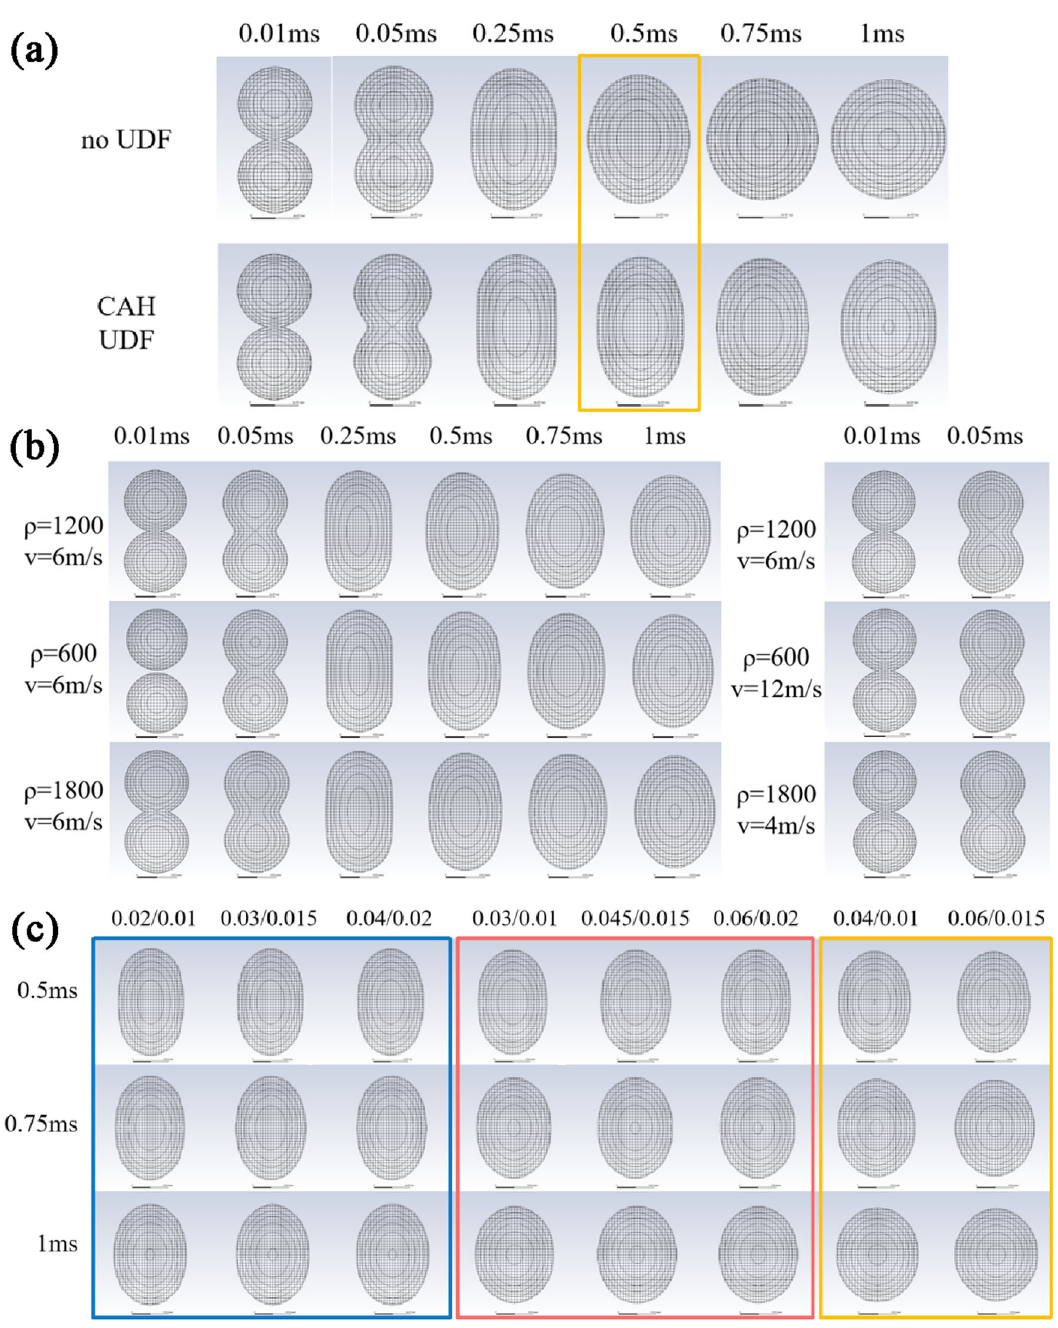
Fig. 4 Results of two droplets fusion simulation. a Simulated two-droplet fusion morphology of cases without a UDF and with the CAH UDF. b Simulated two-droplet fusion morphology of cases with different densities and impact velocities. c Simulated two-droplet fusion morphology of cases with different surface tensions and viscosities. All pictures are top views of simulated two-droplet fusion morphology. a Shows the difference between cases without UDFs and with CAH UDF. b Results reveal that the in fl uence of impact velocity and density mainly worked in the early stage(<0.05 s) and can be ignored in the whole printing process. c Shows that the same value of surface tension/ viscosity is the major factor that determines the simulated morphology at different function. In contrast, for cases with the Hoff UDF, the simulated derived from simulation results. θ d is directly estimated from the points have a higher θ d than the theoretical value. These results pro fi le image, and v contline is calculated as UDMI i and read from the results. In addition to v contline , the ratio of surface tension and indicate that the basic VOF method in FLUENT is able to reproduce viscosity γ / η determines the capillary number Ca. The simulated the Hoffman function. For cases with the CAH UDF, the applied results and curves of the Hoffman function with different γ / η boundary condition is not too different from 30° to cause obvious and θ s = 30° values are shown in Fig. 3a – c. For cases without UDFs differences when Ca is dominant. For cases with Hoff UDF, the applied boundary condition is much higher than 30°, so the and with the CAH UDF presented in this study, the simulated simulated points have much higher θ d values. Figure 4d shows points are in good agreement with the curves of the Hoffman